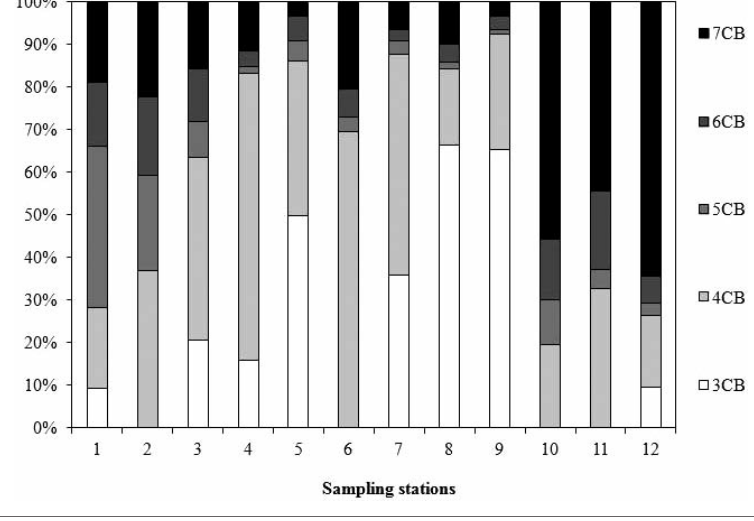
Figure 2. Station-wise distribution of total % of polychlorinated biphenyl homolog in Yamuna River water.